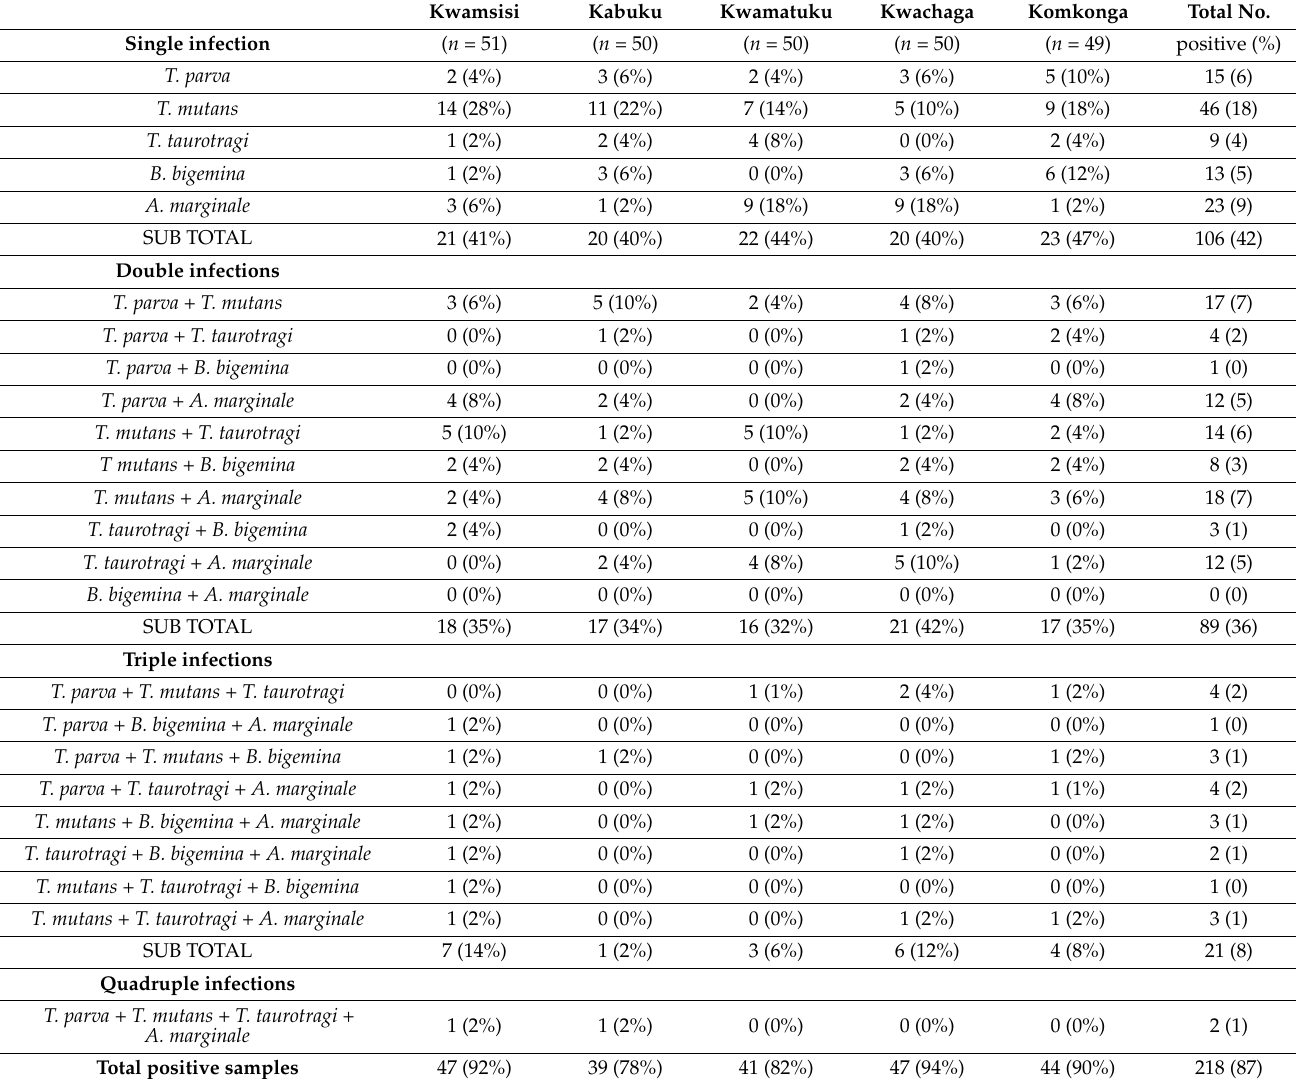
Table 2. Tick-borne pathogens detected from Handeni,